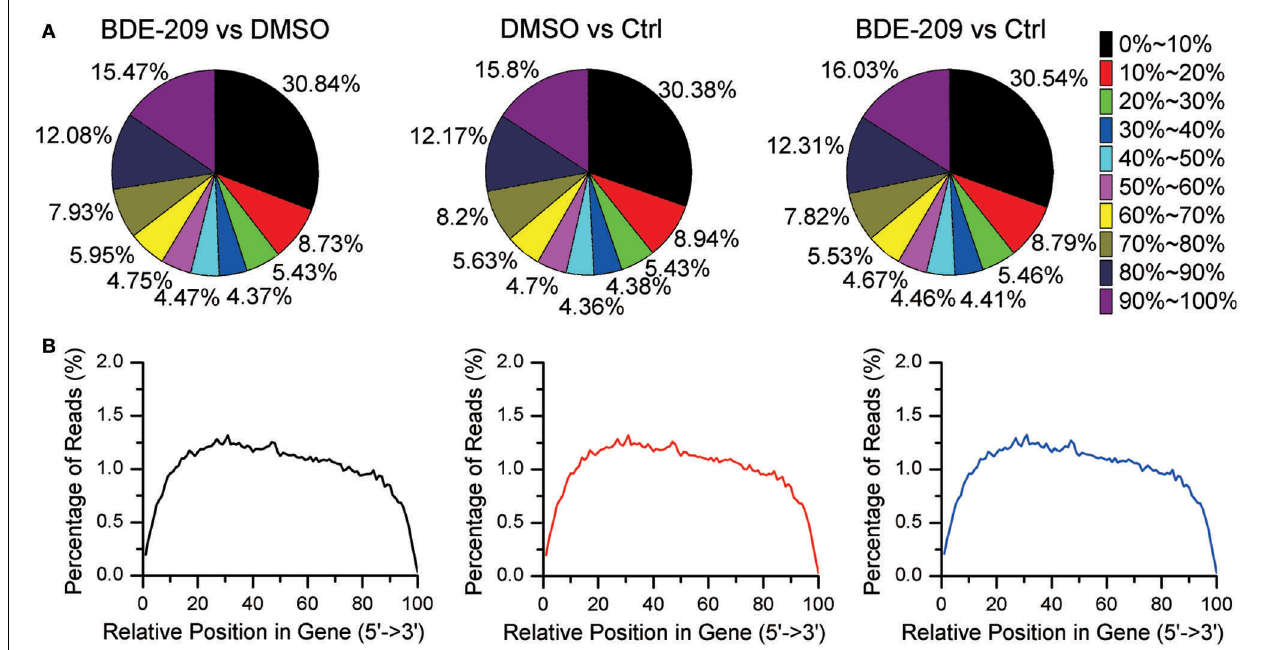
FIGURE 1 | Gene coverage and RNA integrity of RNA sequencing data. (A) Gene coverage is the proportion of a gene region covered by RNA-seq reads and binned with an interval of 10%. Each gene belongs to one of the bin. (B) Distribution of RNA-seq reads along gene